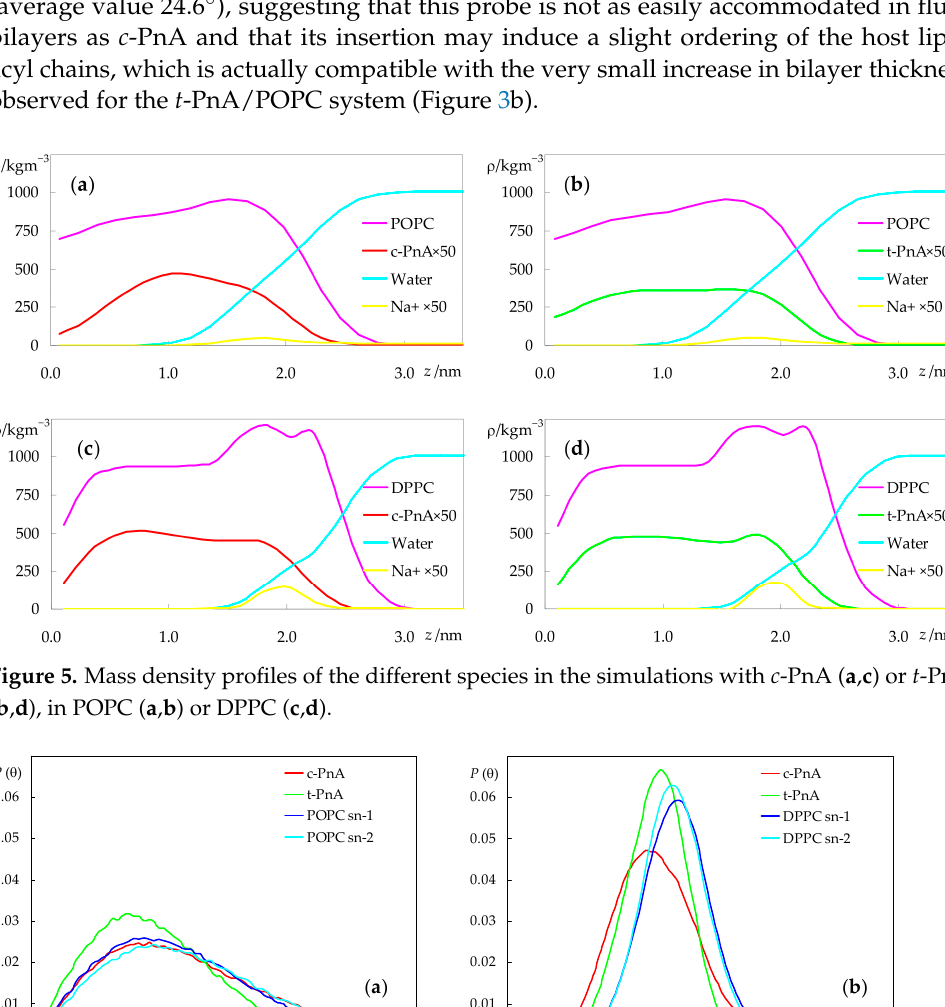
Figure 5. Mass density profiles of the different species in the simulations with c ‐ PnA ( a , c ) or t ‐ PnA ( b , d ), in POPC ( a , b ) or DPPC ( c , d ).